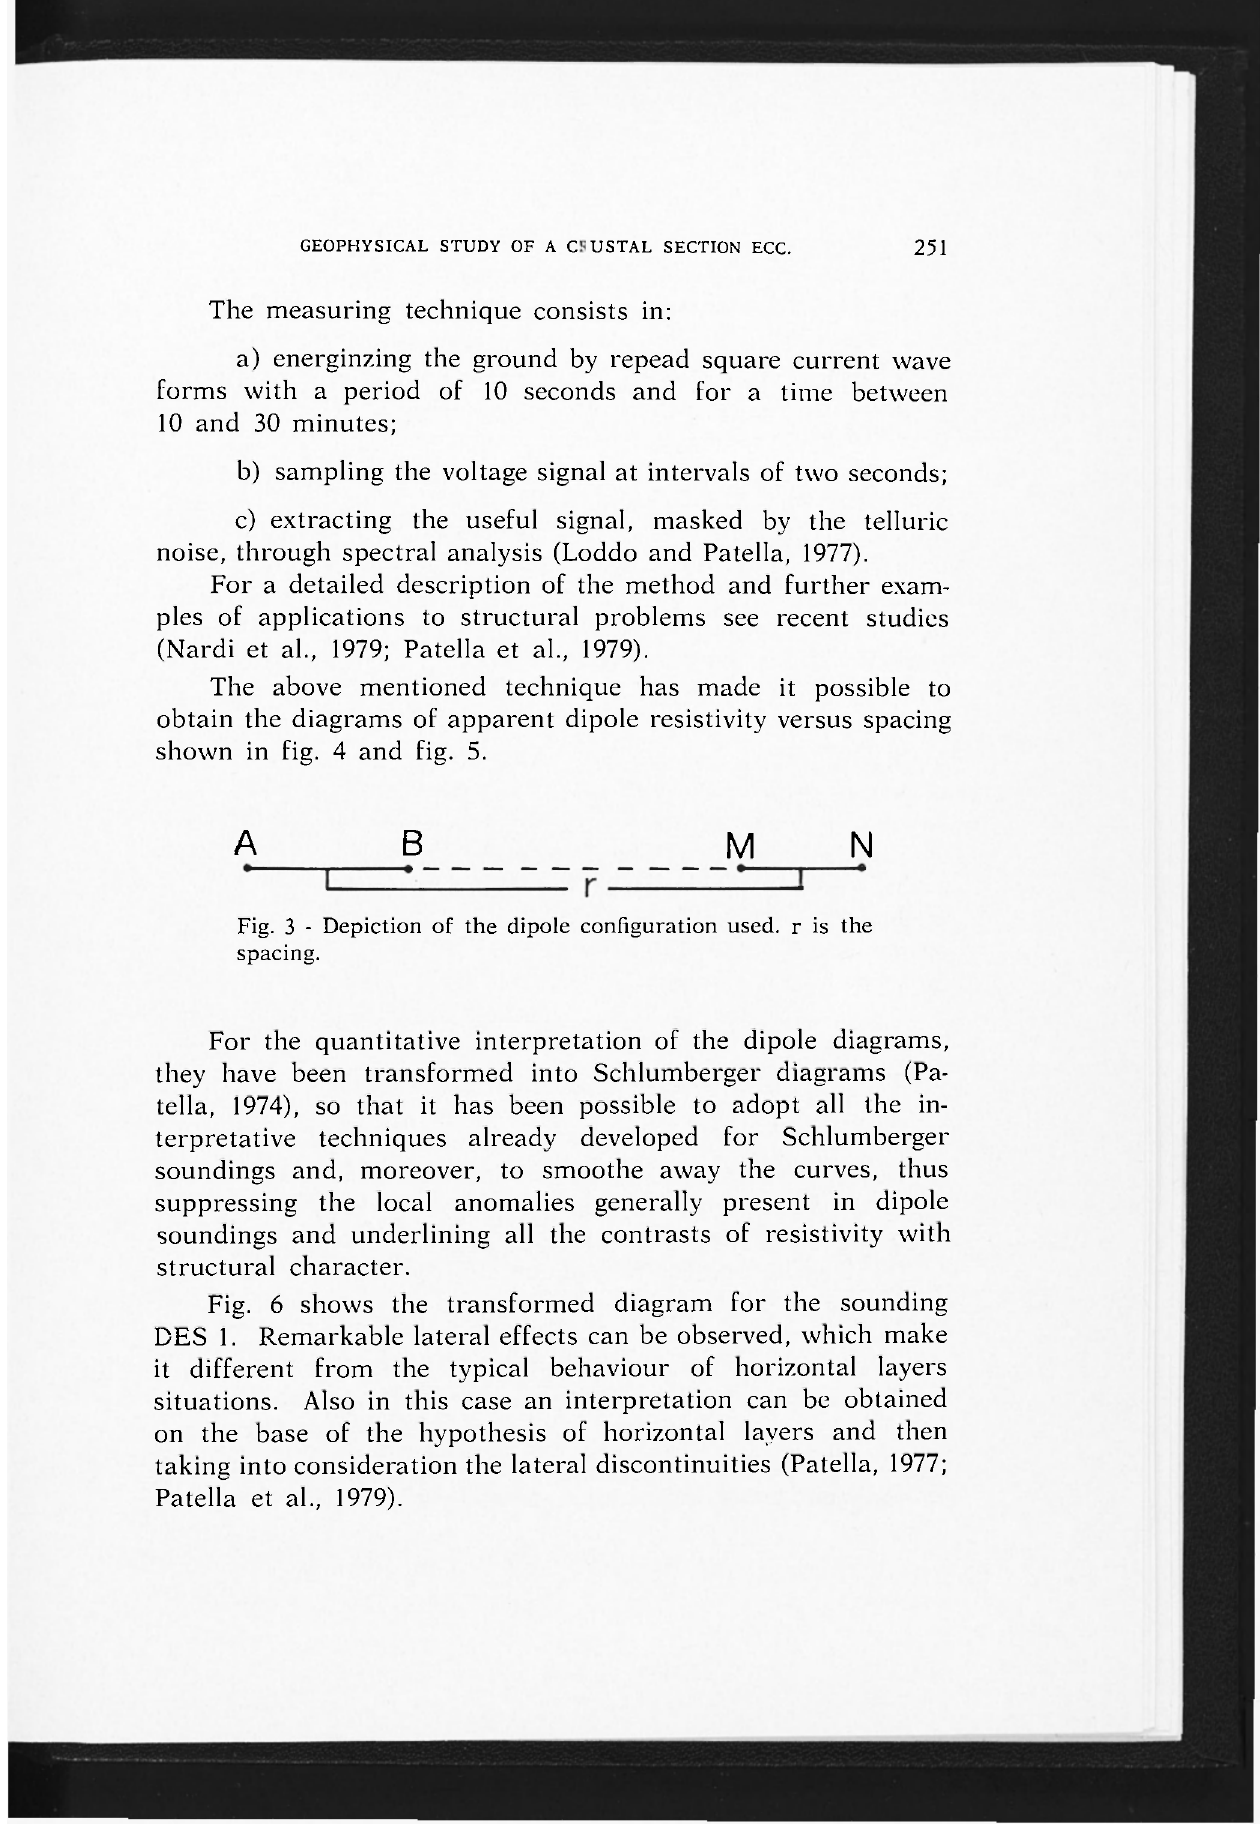
Fig. 3 - Depiction of the dipole configuration used, r is the